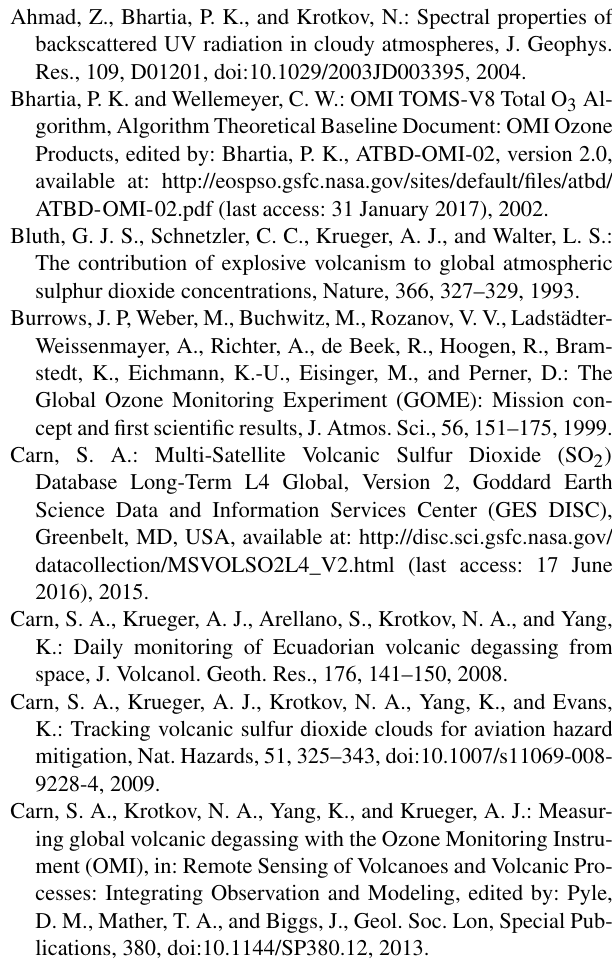
algorithm, the OMSO2VOLCANO algorithm has been